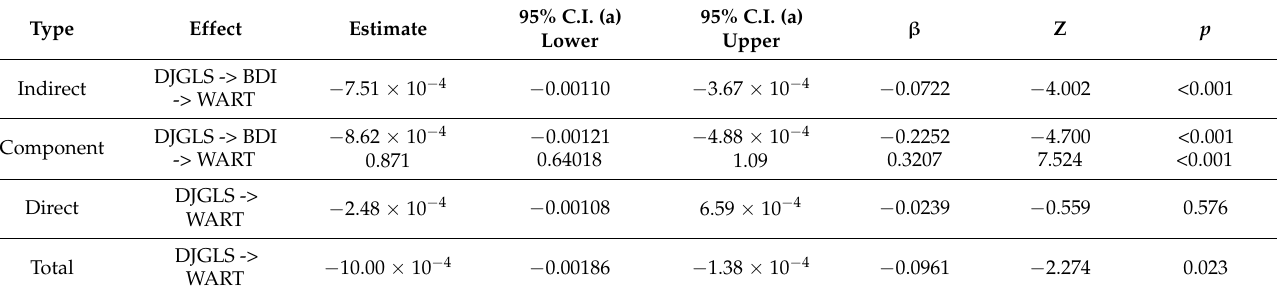
Table 3. Indirect and Total Effects-Mediation model